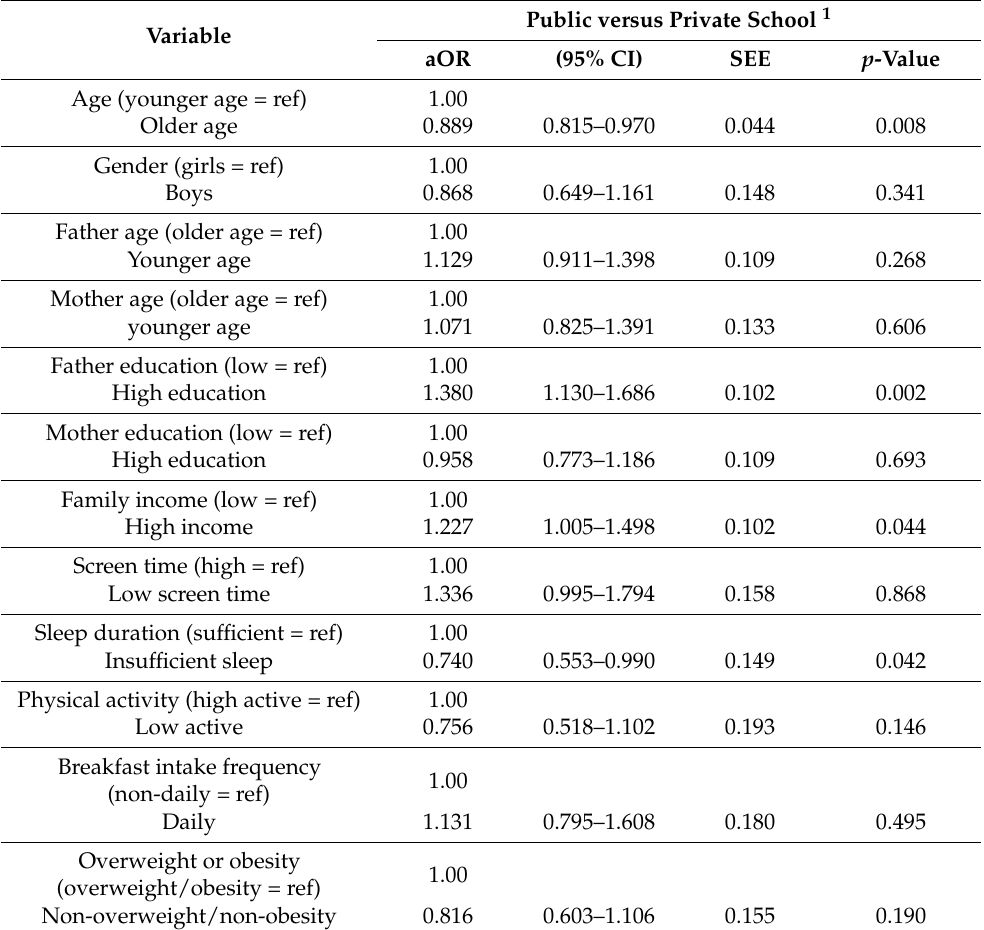
Table 7. Results of logistic regression analysis of selected lifestyle behaviors, adjusted for gender, and socio-demographic factors, relative to school type among Saudi